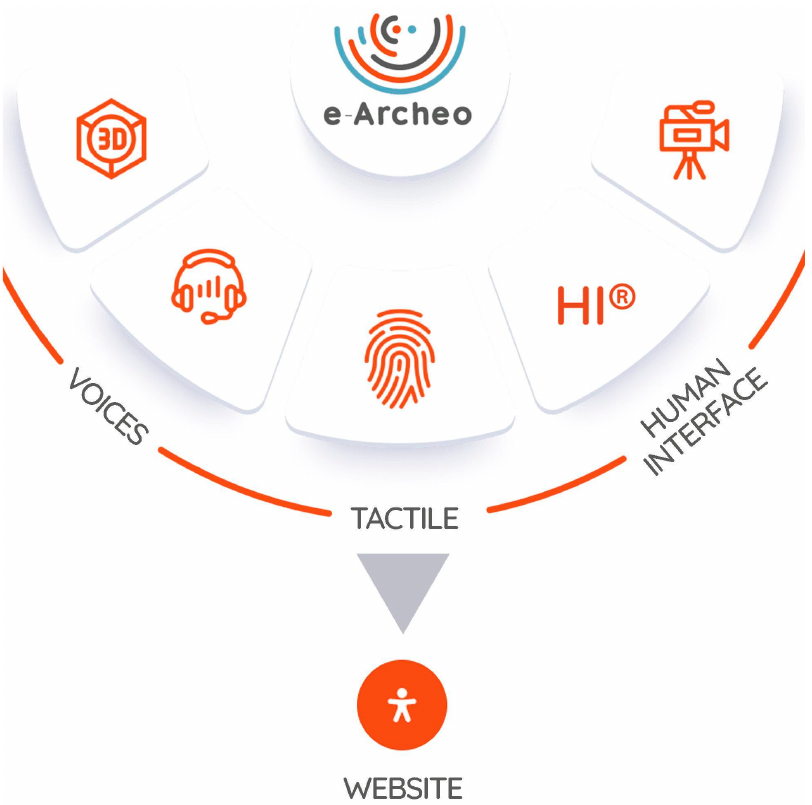
Figure 9. Outputs and logos of the e-Archeo project.